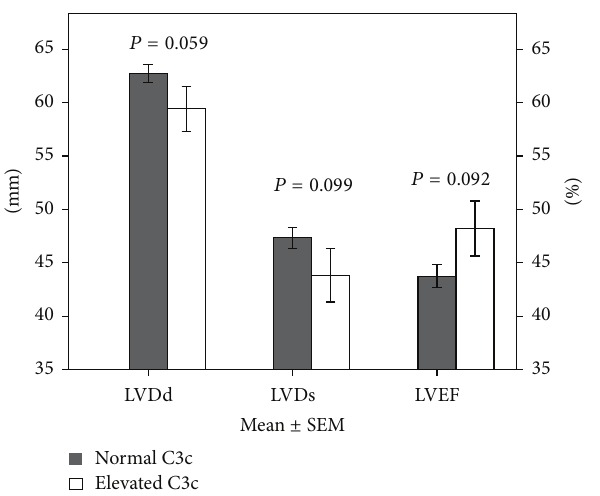
Figure 1: Comparison of echocardiographic parameters in patients with normal versus elevated C3c values. There is a trend towards smaller diastolic ( 59 ± 11 mm versus 63 ± 10 mm; 𝑃 = 0.059 ) and systolic ( 44 ± 13 mm versus 47 ± 13 mm; 𝑃 = 0.099 ) diameter of the left ventricle and higher left ventricular ejection fraction ( 48.0 ± 12.83 % versus 43.5 ± 13.2 %; 𝑃 = 0.092 ) in patients with elevated complement C3c. LVDd, diastolic left ventricular diameter; LVDs, systolic left ventricular diameter; LVEF, left ventricular ejection fraction.